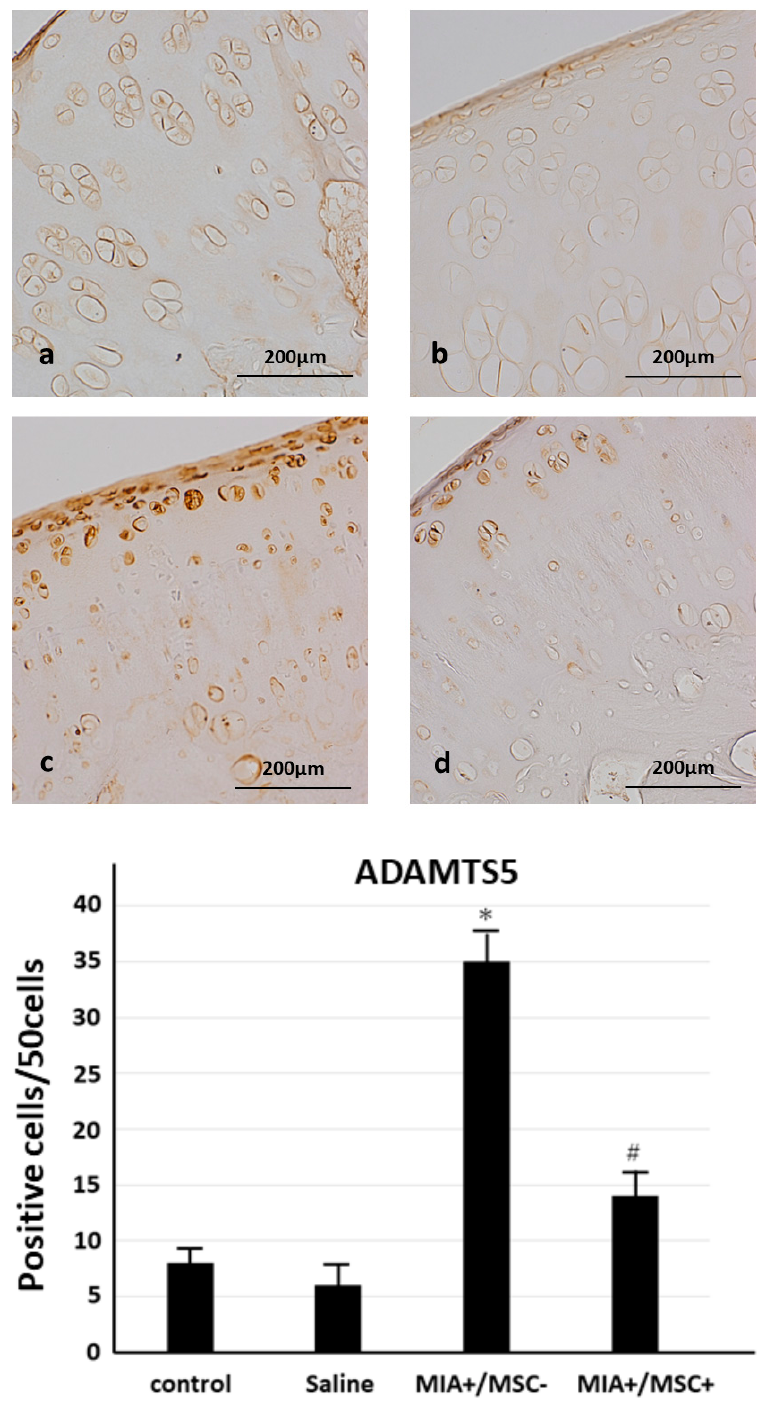
Figure 4. ADAMTS5 expression in cartilage tissue. ( a ) control group, ( b ) Saline group, ( c ) MIA+/MSC − group, ( d ) MIA+/MSC+ group. Control group and Saline group: Almost no ADAMTS5 is found in cartilage cells. MIA+/MSC − group: ADAMTS5 is extensively expressed from the hypertrophied cartilage layer to surface layer of cartilage cells. MIA+/MSC+ group: ADAMTS5 expression in cartilage cells is greater than in control and Saline group, but as compared with MIA+/MSC − group, ADAMTS5 expression is diffuse and clearly. A significant increase in ADAMTS5 expression is found in the MIA+/MSC − group. In the MIA+/MSC+ group as compared with A, B, it is increased, while as compared with the MIA+/MSC − group it is significantly decreased. * p < 0.001 compared to the untreated control. # p < 0.001 compared to the (MIA+/MSC − ) group.